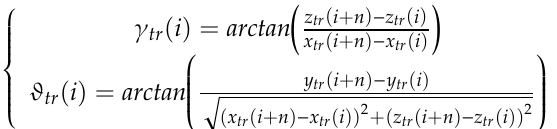
ϑ tr of the UAV flight speed vector.